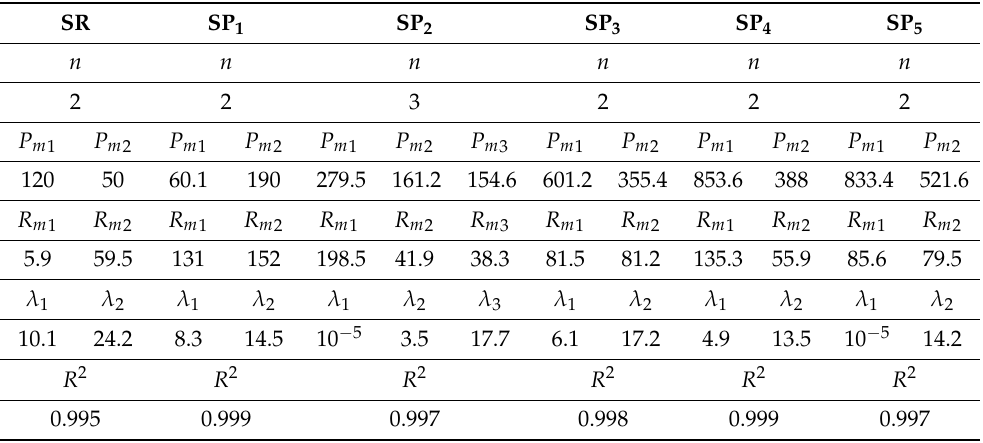
Table 6. Parameters of new Gompertz model (Equation (9)) obtained from the interpolation of